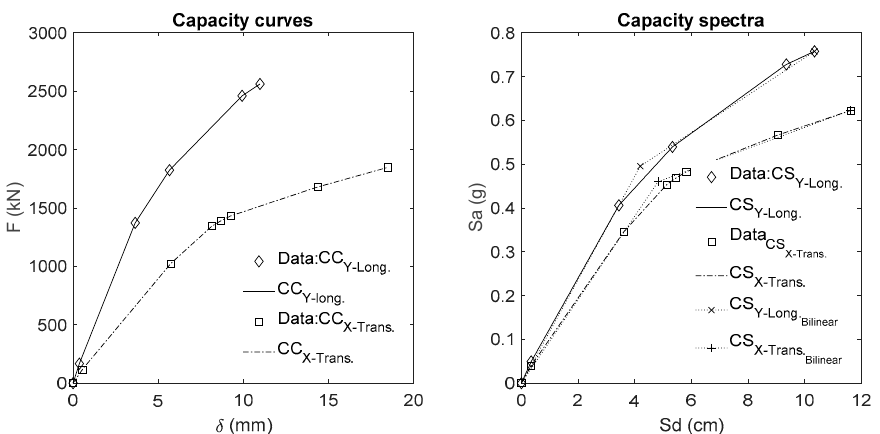
Figure 8. Capacity curve and spectra in the X and Y directions. The points resulting from the pushover analysis, the interpolated curves (int) at a fixed step, and the bilinear forms (Bilinear) are shown.